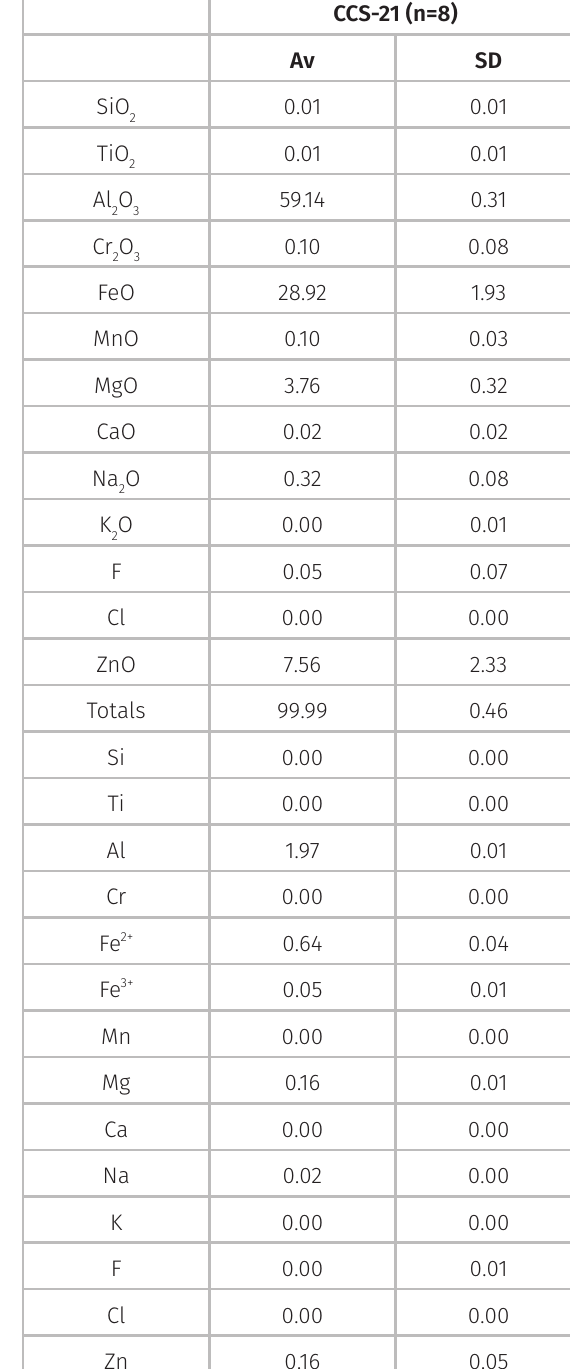
Table V. Average (Av) and standard deviation (SD) of the mineral chemistry of spinel. Calculations based on 4 oxygens, following the methodology of Droop